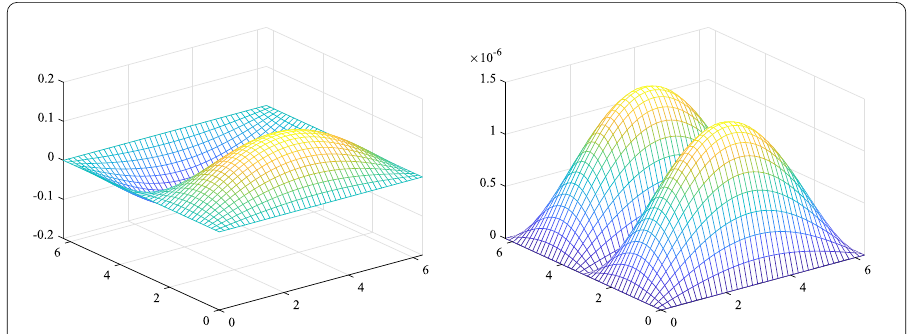
Figure 5 The E-CFDS6-SSM solution (left-hand side) and error of E-CFDS6-SSM (right-hand side) when J = 41 and t = 2 for SP 2